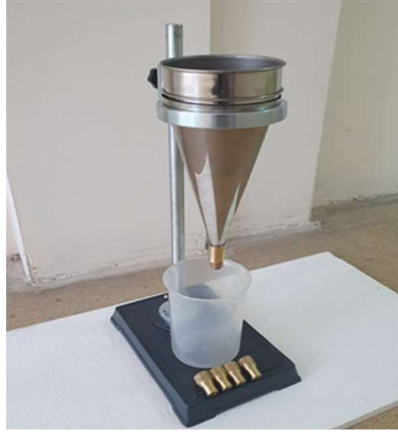
Figure 7. Flow cone.